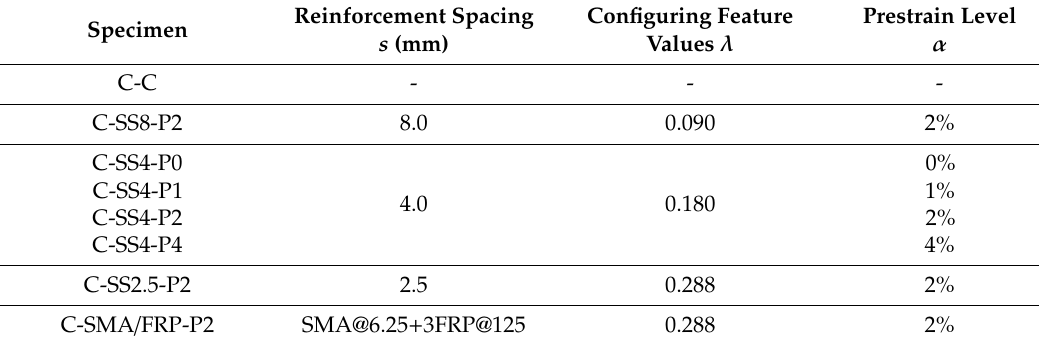
Table 3. Test piece design.